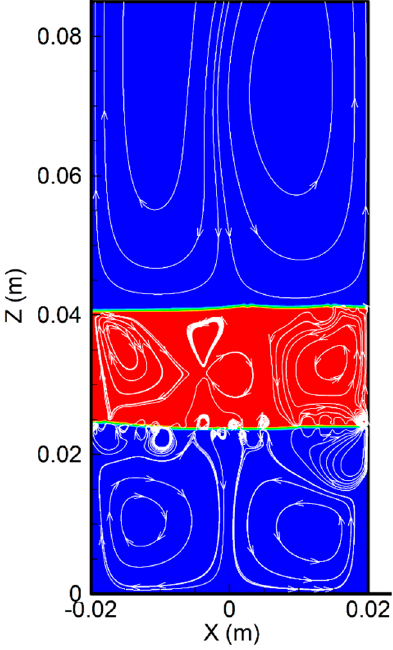
Figure 7. Distribution of flow streamlines (white line) at 600 s with a heating temperature of 1873 K.